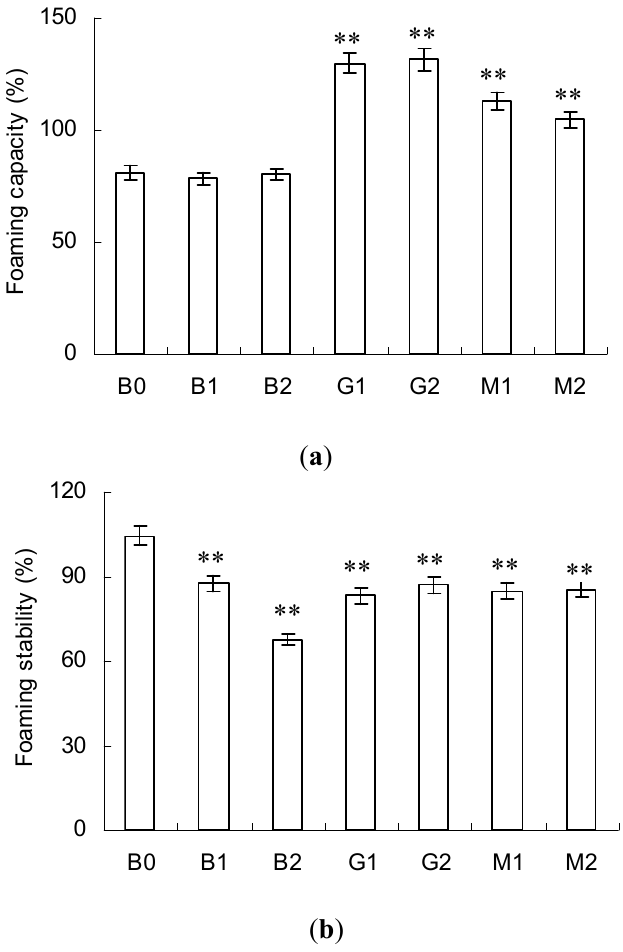
Figure 5. Foaming capacity ( a ) and foaming stability ( b ) of BSA, BSA–glucose and BSA–mannose at intensities 10 and 20 kV/cm. Data are mean ± standard deviation, n = 3. ** p < 0.01 versus control (B0).